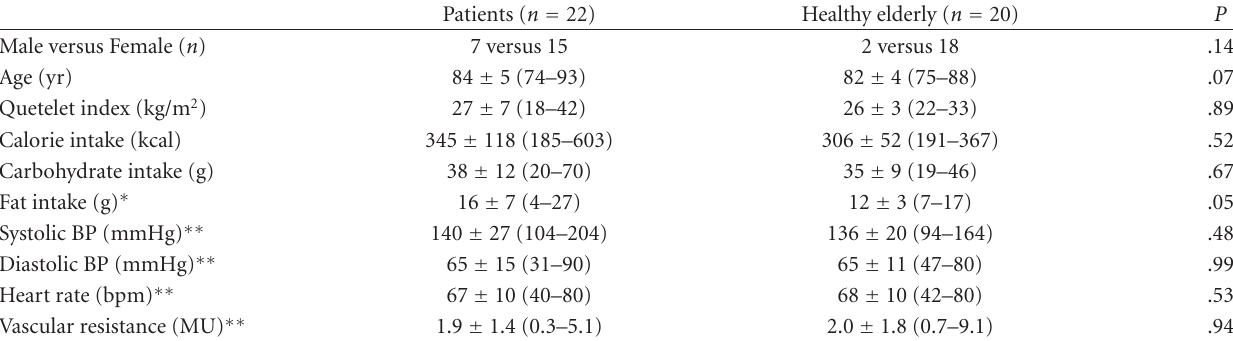
Table 2: Baseline characteristics of patients admitted to a geriatric ward and of healthy elderly